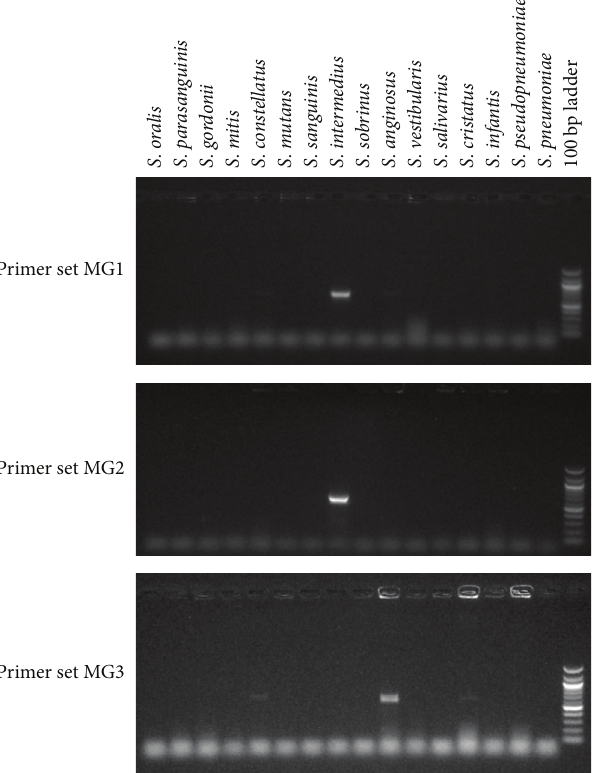
Figure 5: Primer sets MG1, MG2, and MG3 were evaluated for specificity by testing for amplification of a PCR product from DNA isolated from a panel of ATCC type strains representing species typically found in the oral cavity. Representative gels are